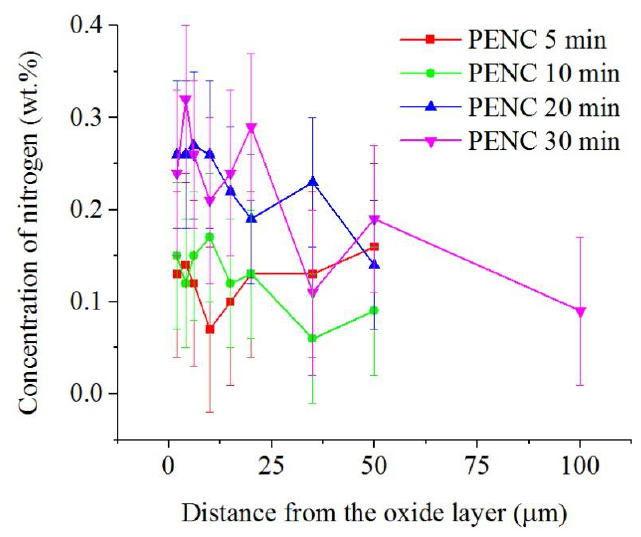
Figure 5. EDX nitrogen distributions in the nitrocarburzsed layer after cathodic PENC.